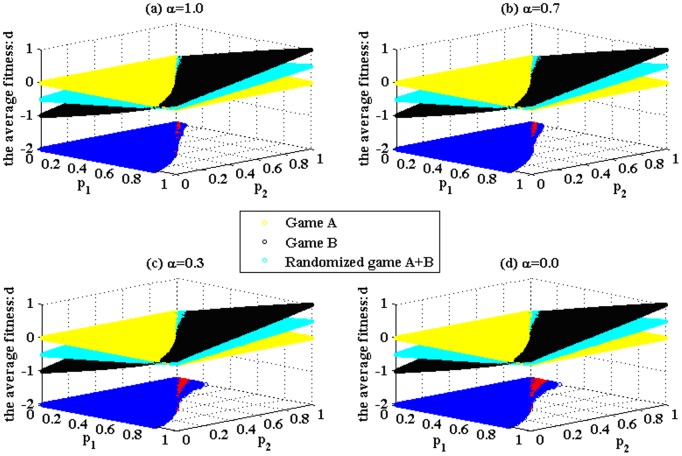
Simulations based on the networks, which progressively change from a random network to a scale-free network.The population size N is 900. The average degree of the network is four and the average number of playing times T of each individual is 100. The probability of playing game A is p = 0.5. Play the games 30 times with different random numbers, and draw the corresponding figures according to the average results of the games. The blue area in the picture demonstrates the weak Parrondo’s paradox area, whereas the red denotes the strong area. Figures. 5 (a), (b), (c) and (d) correspond to the networks with the parameter α = 1.0, 0.7, 0.3 and 0.0, respectively.